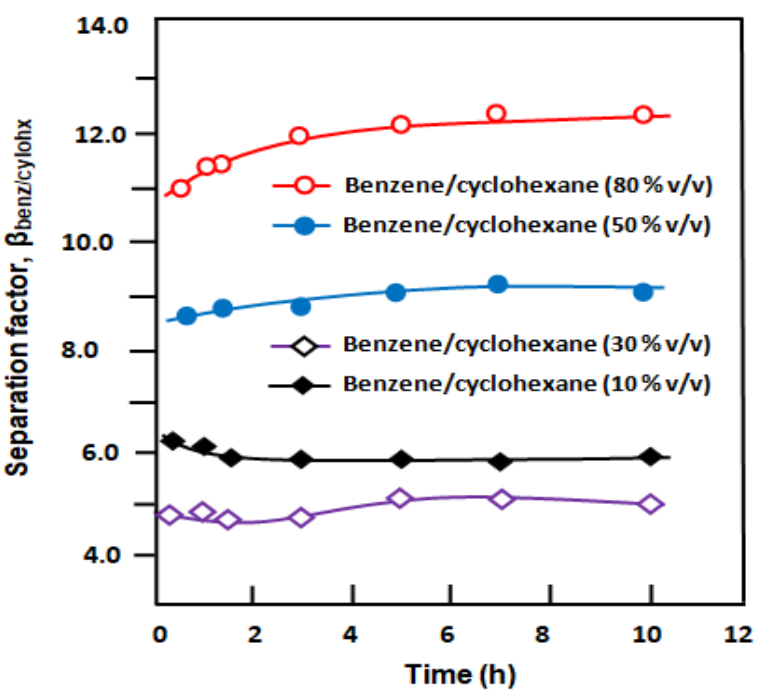
Figure 13. Change in the separation factor for benzene/cyclohexane mixture with different compositions versus time in the E-VOH/CNT-membrane.